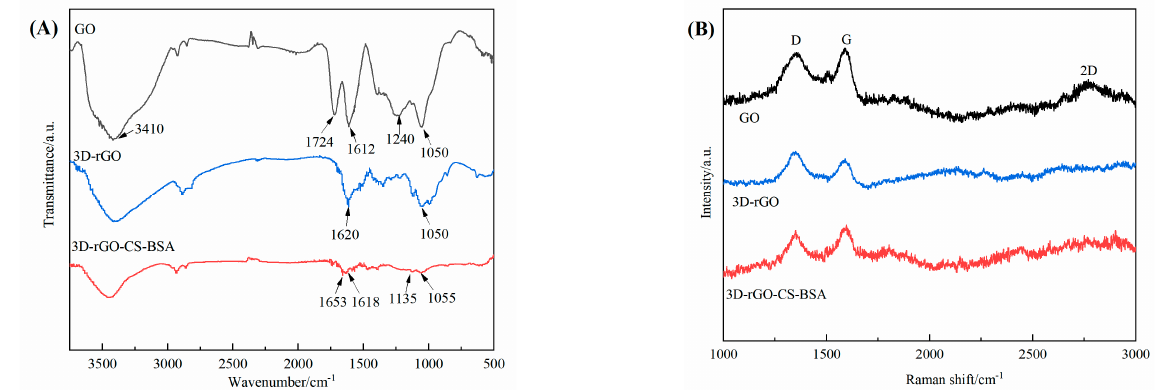
Figure 3. ( A ) FT–IR and ( B ) Raman spectra of GO, 3D–rGO, and 3D–rGO–CS–BSA.